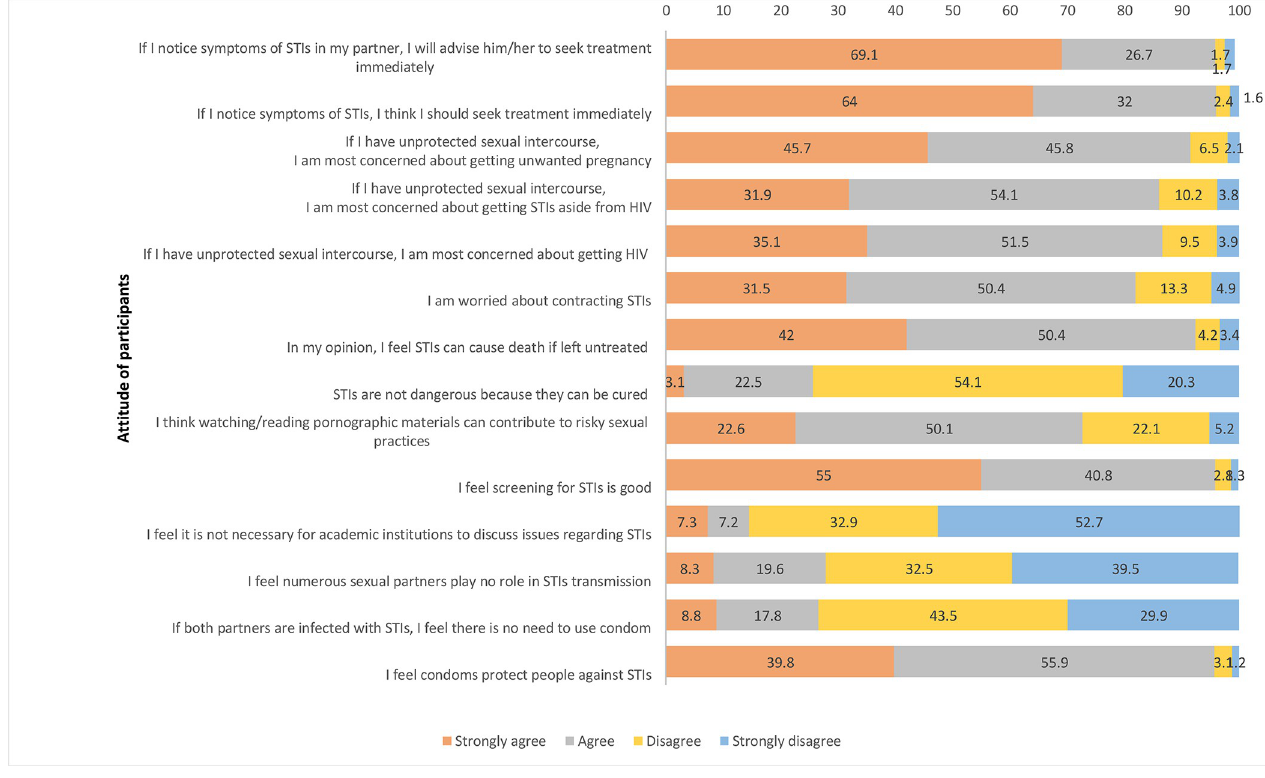
Fig 3. Attitude of participants towards STIs in university students of